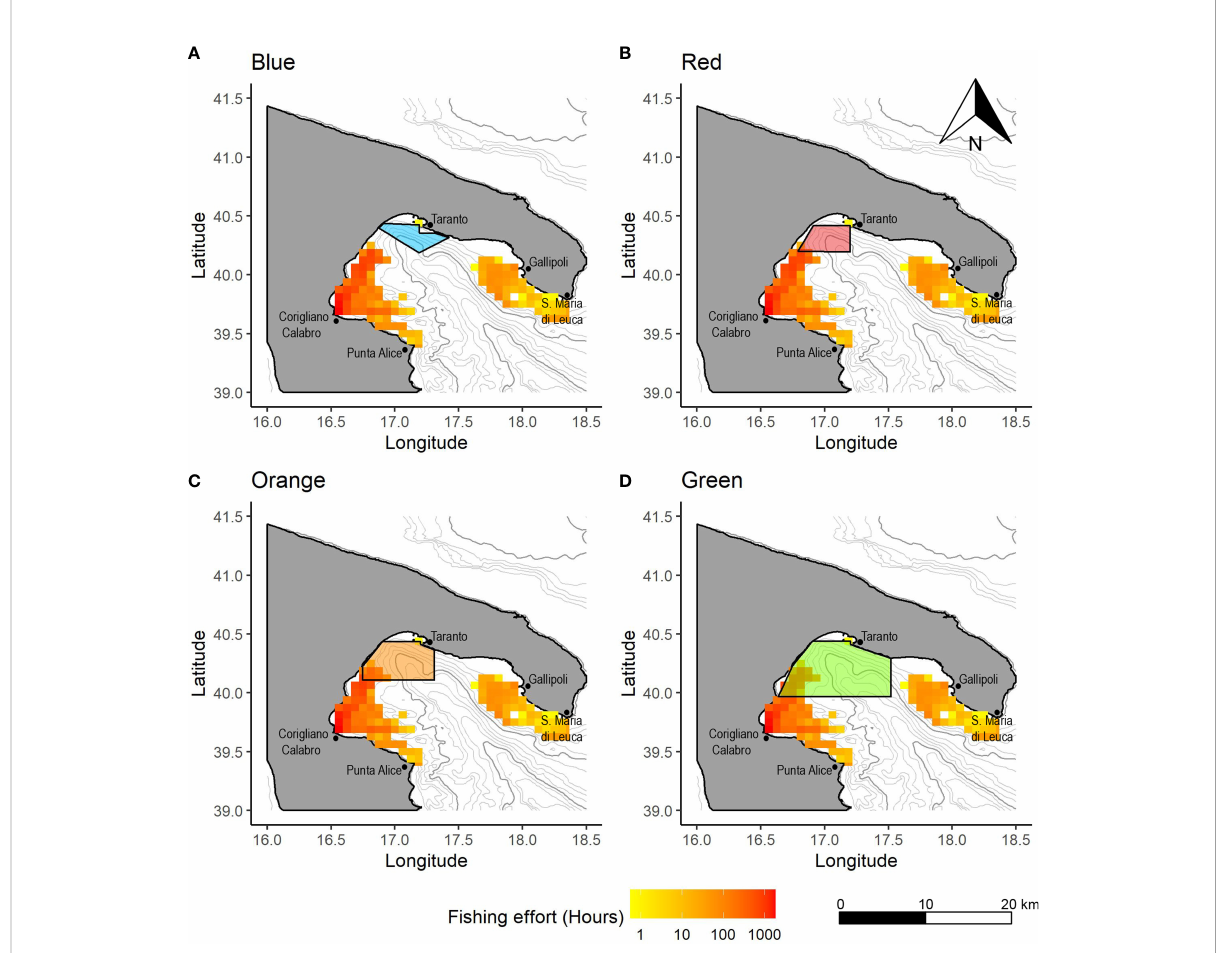
FIGURE 5 Spatial distribution of the OTB effort (in hours) by VL 18-24 showing the overlap with the (A) Blue, (B) Red, (C) Orange and (D) Green CCAs. Values in hours are calculated as yearly averages for the period